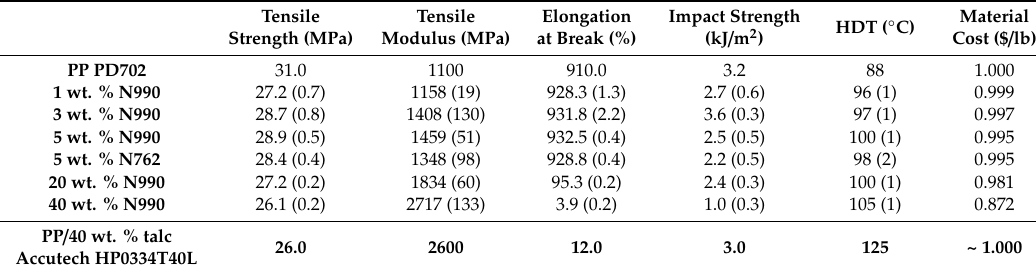
Table 2. Properties (and SD) of PP / TB N990